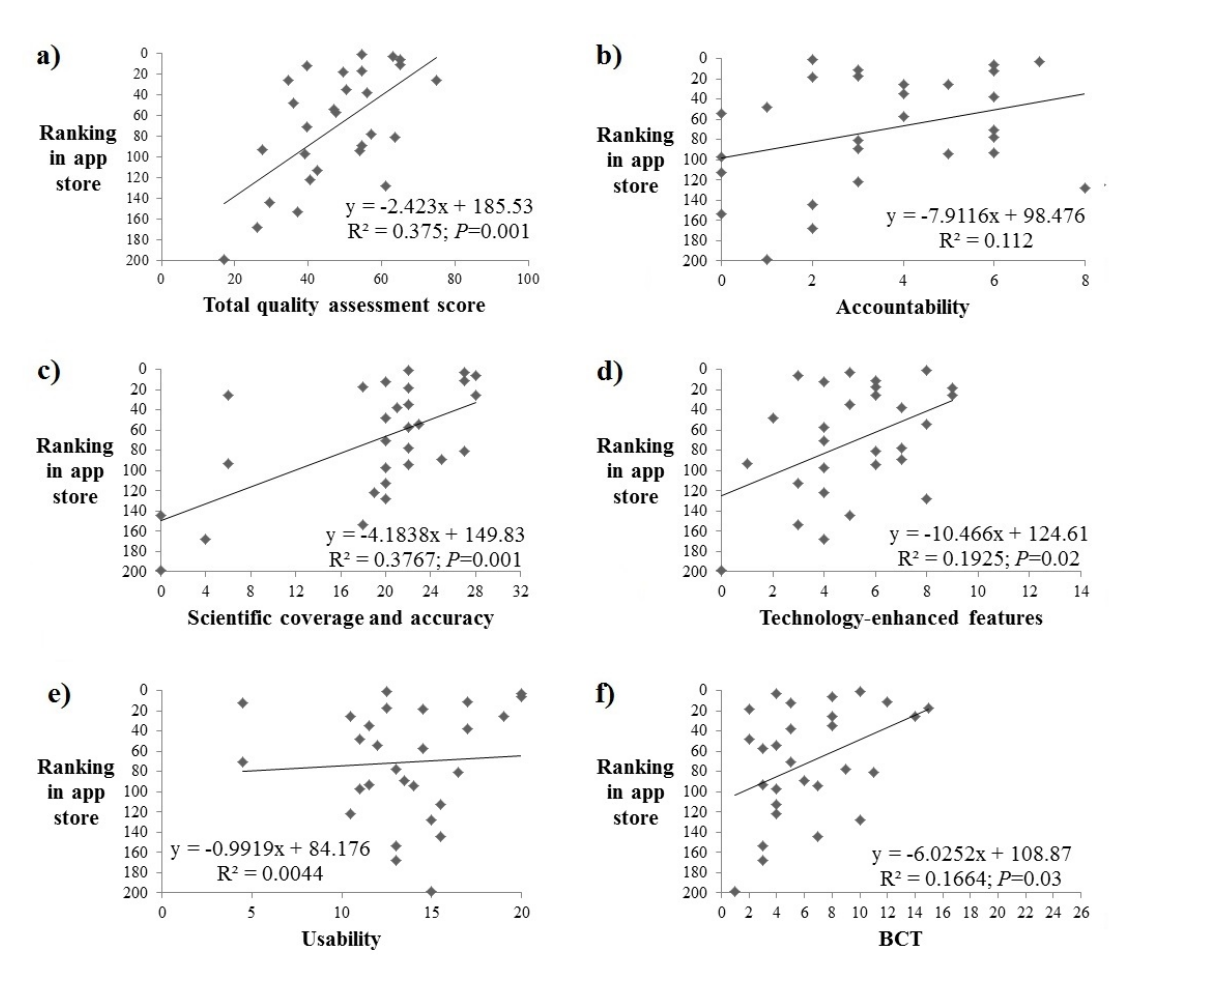
Figure 2. Regression analyses of the association between the rankings in the commercial app store (ie, popularity) versus quality assessment measures: (a) overall quality assessment score, (b) accountability, (c) scientific coverage and accuracy, (d) technology-enhanced features, (e) usability, and (f) behavior change technique (BCT). Note: ranking is numerical, with the rank of most popular apps starting from 1 and the least popular app ranked at